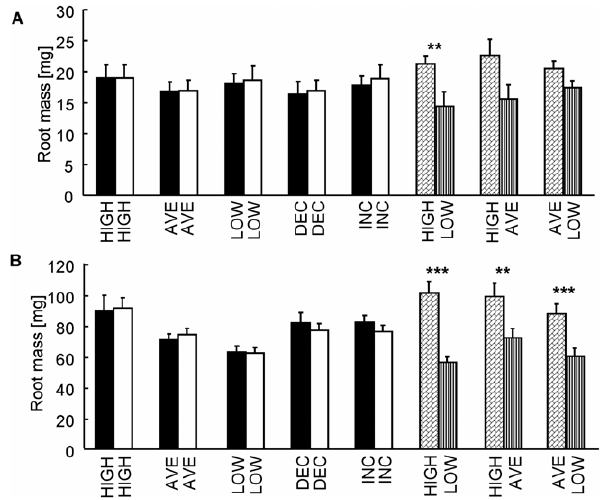
Figure 2. Patch choice in the homogenous and stationary heterogeneous treatments. Biomass of individual roots of split-root plants at the interim (a) and final (b) harvests of homogenous (black and white bars) and stationary heterogeneous (striped and checkered bars) treatments. Pair-wise comparisons were done using Wilcoxon Signed-rank Test; * , 0.05, ** , 0.01, *** , 0.001. Values are means 6 1 S.E.